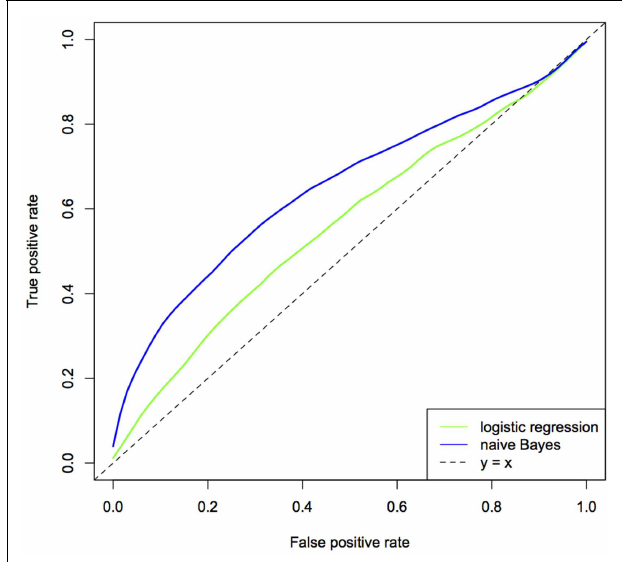
FIGURE 4 | Comparison of logistical regression and naïve Bayes ROC curves .The predictor set contains 45 different predictors, including measures of respiratory infections, immune function, lung function, and maternal and environmental factors.The ROC curve was generated using 100 × 3-fold